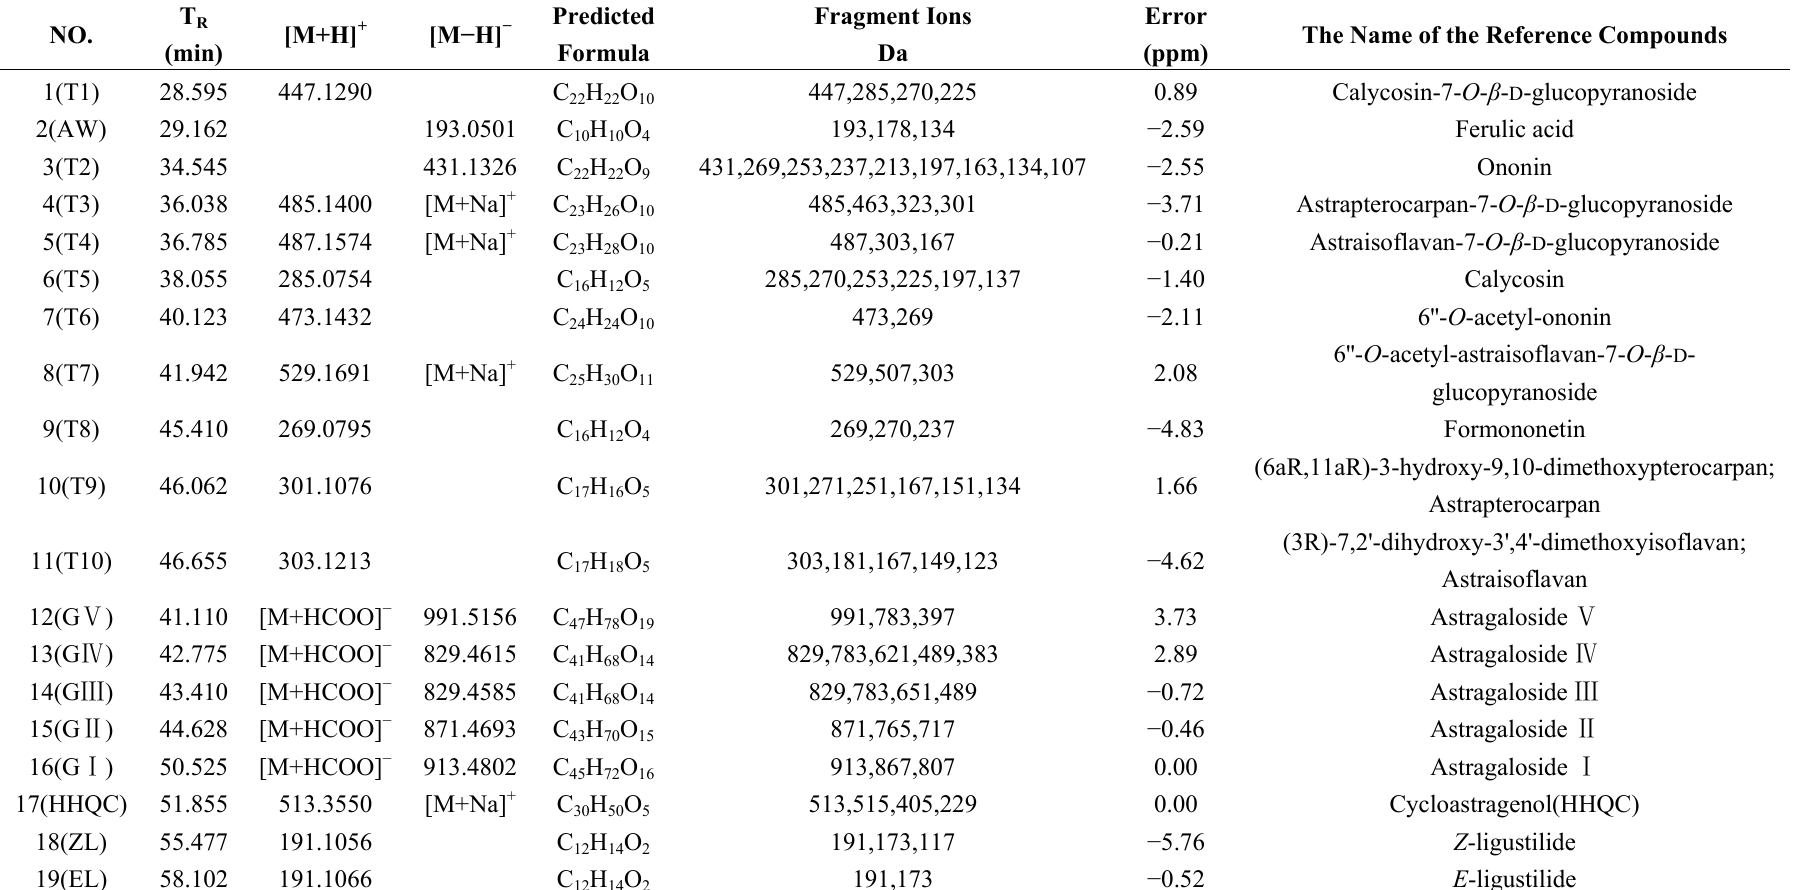
Table 1. The fragment ions of 19 kinds of reference compounds by HPLC-DAD-ESI-IT-TOF-MS n